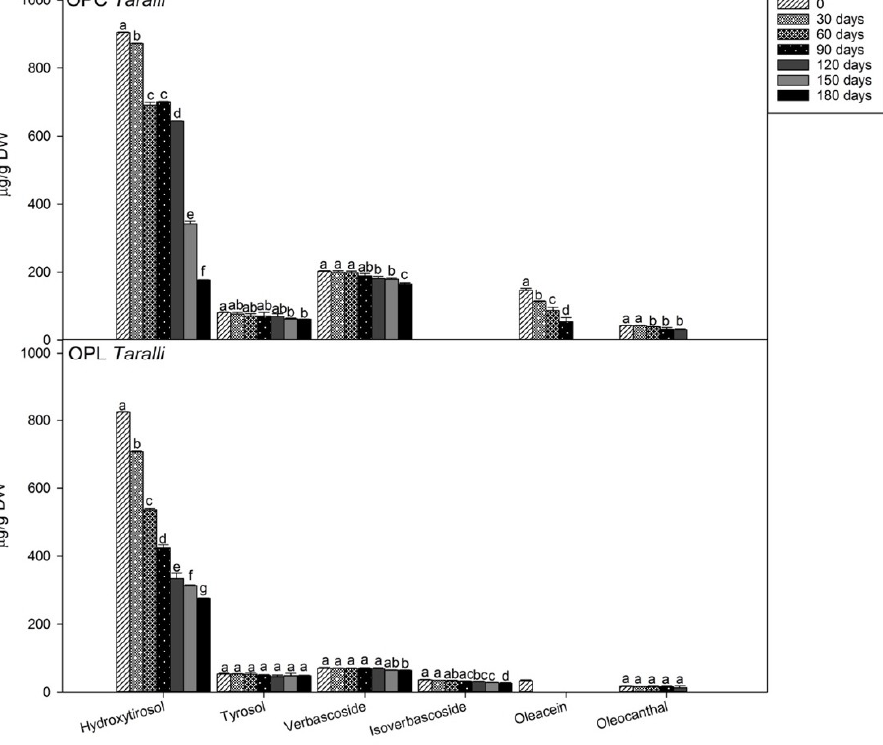
Figure 2. Time course of the amounts of polyphenols during the storage of CTRL and taralli enriched with fermented olive paste from Cellina di Nardò (OPC) or Leccino (OPL) olive cultivars at 25 °C, 500 lux, and in clear plastic bag for 180 days. Data are the mean ± standard deviation of three independent replicates ( n = 3). Data were submitted to one-way analysis of variance (ANOVA), Tukey’s test was applied to compare the experimental times (0, 30, 60, 90, 120, 150, 180 days) within the same sample for each compound (hydroxytyrosol, tyrosol, verbascoside, isoverbascoside, oleacein, and oleocanthal). Different letters mean significant difference at p < 0.05.